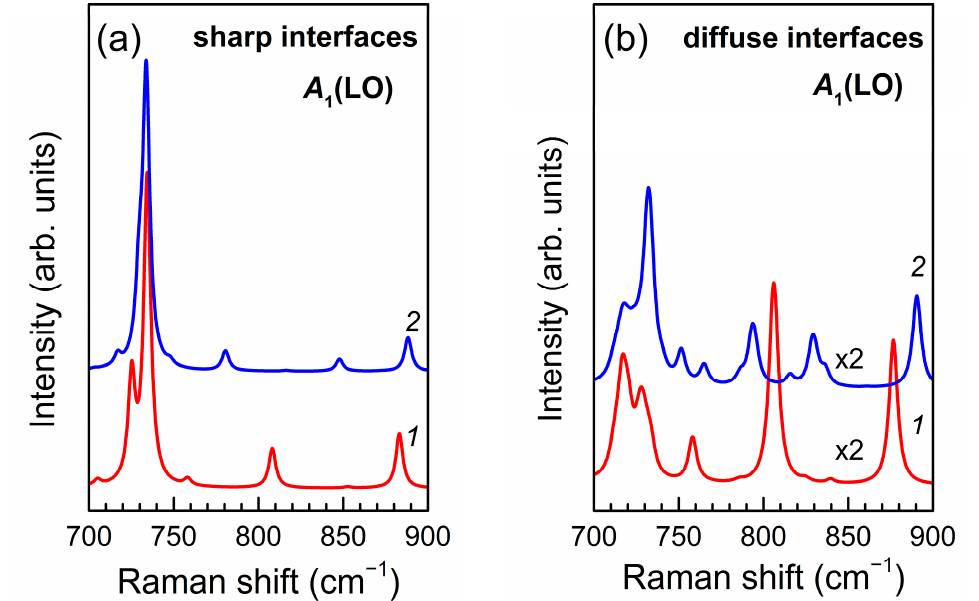
Figure 10. Ab initio simulated Raman spectra of (GaN) m /(AlN) m SLs with the sharp interfaces ( a ) and spectra of SLs with diffuse interface layers ( b ). Red line ( 1 ) corresponds to m = 4, blue line ( 2 ) corresponds to m = 6.